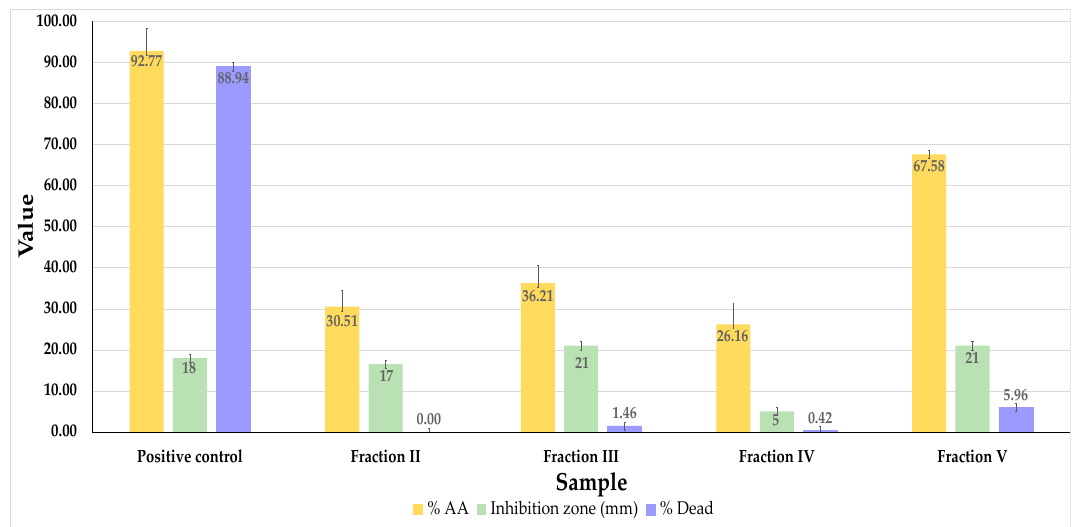
Figure 4. Antioxidant activity (expressed in % AA), antibacterial activity against Gram-positive S. aureus (expressed in inhibition zone diameter, mm), and general toxicity (expressed in % dead A. salina ) of fractions II-V. AA, antioxidant activity. Positive controls: antioxidant activity (quercetin); mortality (potassium dichromate); and antimicrobial activity (vancomycin). 2.3.2. Assessment of the Cytotoxic Effect of Plectranthus hadiensis var. hadiensis Ex-